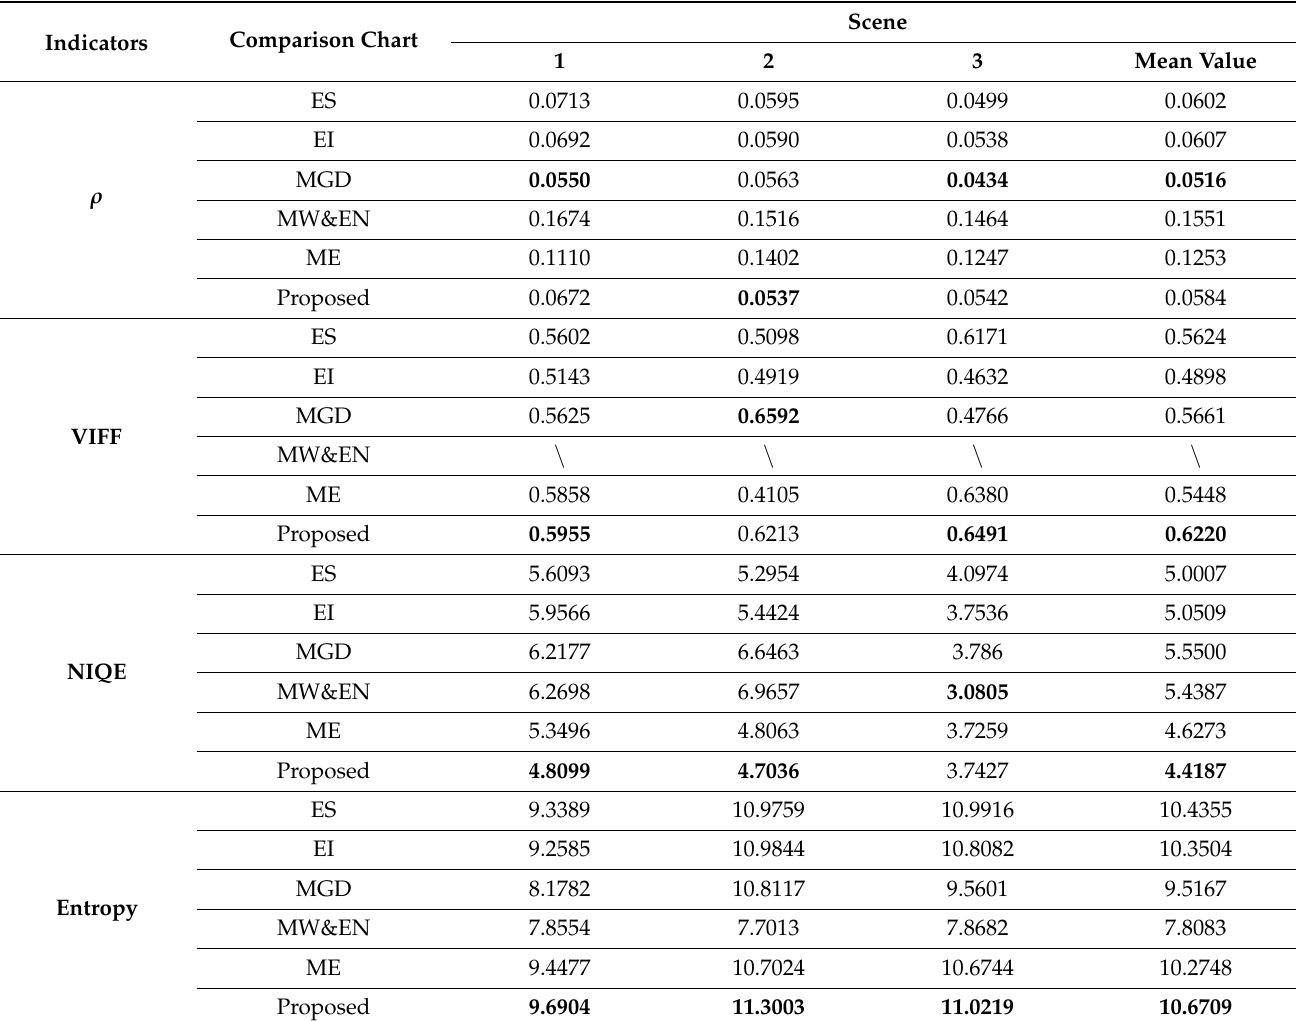
Table 3. Evaluation results of image indicators for the three groups of